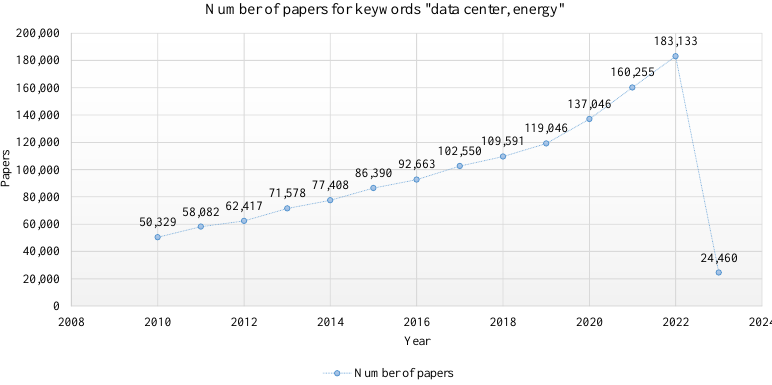
Figure 1. Research trend in energy demand for data centers (sciencedirect.com on 19 December 2022 at 2.30 p.m. KST).